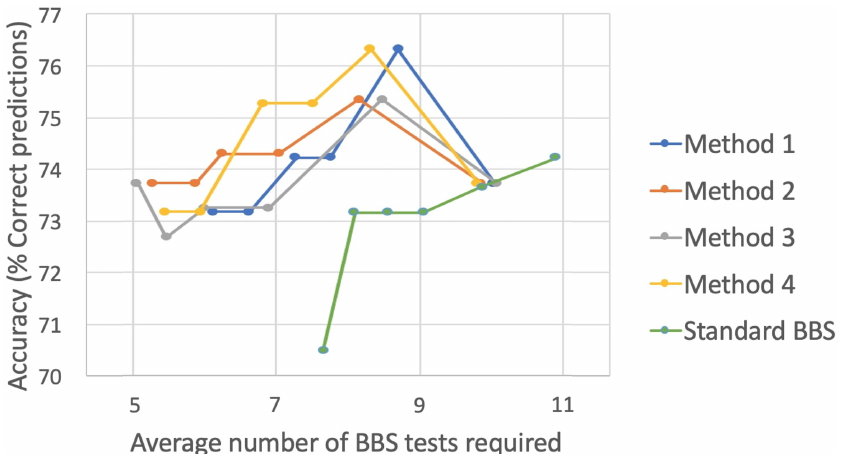
Figure 8. Accuracy vs. average number of BBS tests for different selector methods (Section 5.2) trained on the automatic BBS scoring. For each method, the plot shows values for 6 different confidence thresholds (90, 92, 94, 96, 98, and 100).